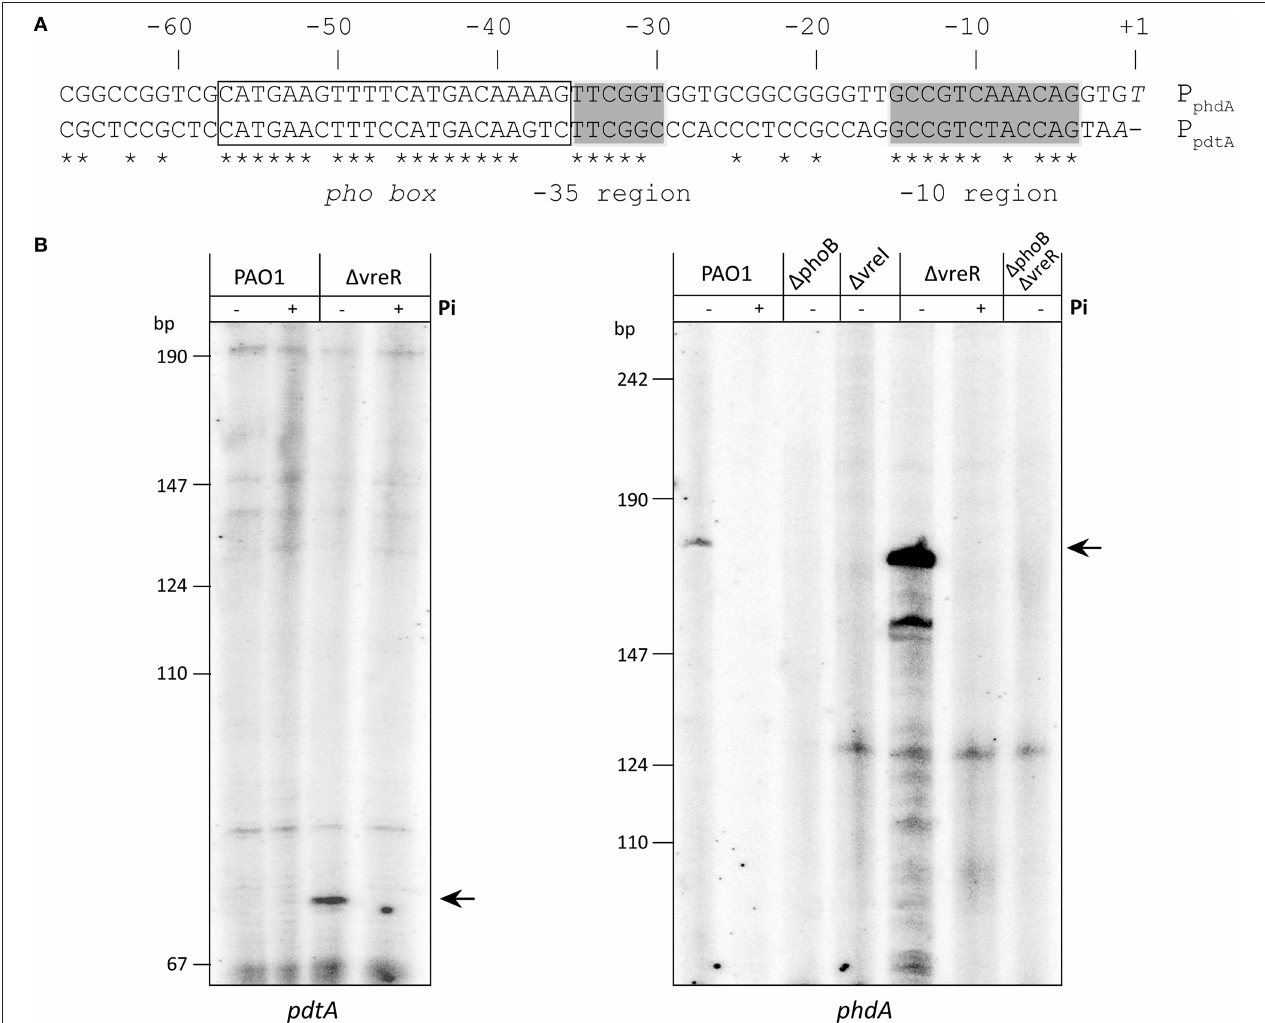
FIGURE 4 | Determination of the transcription initiation points of the pdtA and phdA genes. (A) Identification of the + 1 site by 5 ′ RACE and pdtA and phdA promoter analysis. The P. aeruginosa PAO1 genomic sequence corresponding to the region upstream of the pdtA and phdA gene is shown. Nucleotides in italic represent the proposed + 1 site. The identified promoter elements ( pho , − 35 and − 10 boxes) are indicated. Identical nucleotide residues in both promoter regions are marked with a star. (B) Primer extension analysis of pdtA and phdA mRNA. P. aeruginosa PAO1 cells and the indicated mutants were grown in low or high Pi medium, and samples were taken in stationary phase for total RNA isolation. The autoradiogram shows the cDNA products obtained after reverse transcription of 12 µ g of total RNA with the 5 ′ -end-labeled PA0690R or PA0691R oligonucleotides (Table S1) hybridizing with the pdtA or the phdA mRNA,